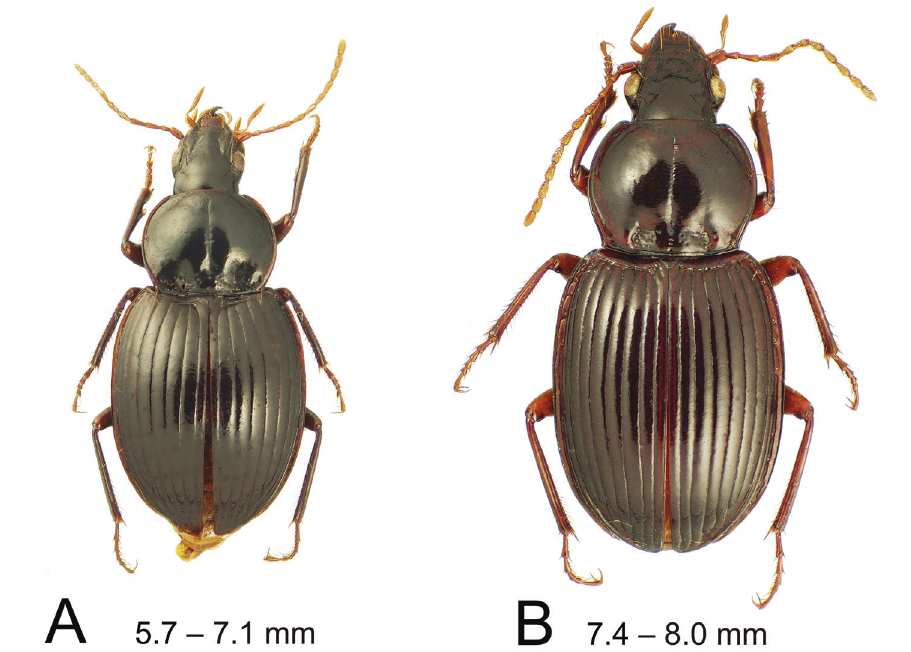
Figure 2. Dorsal habitus illustrations of Theprisa spp.; range of standardized body lengths indicated A T. australis male B T. darlingtoni ,